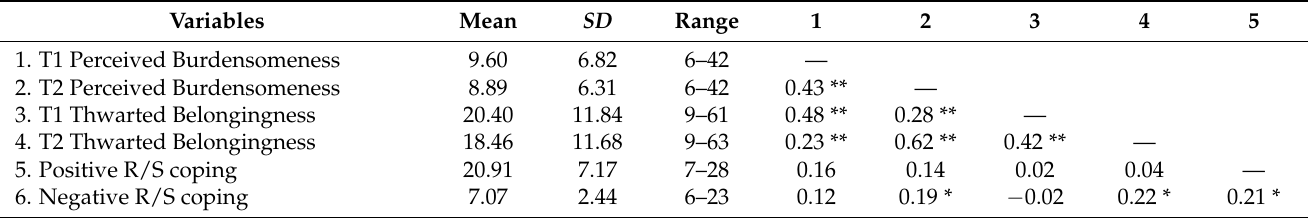
Table 1. Descriptive Statistics and Correlations ( N = 209).